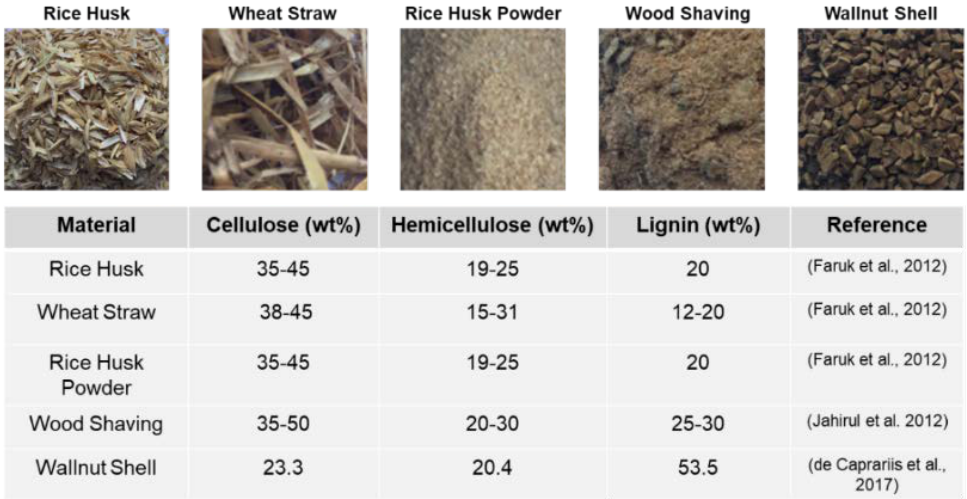
Figure 19 Compositions of Feedstocks Used